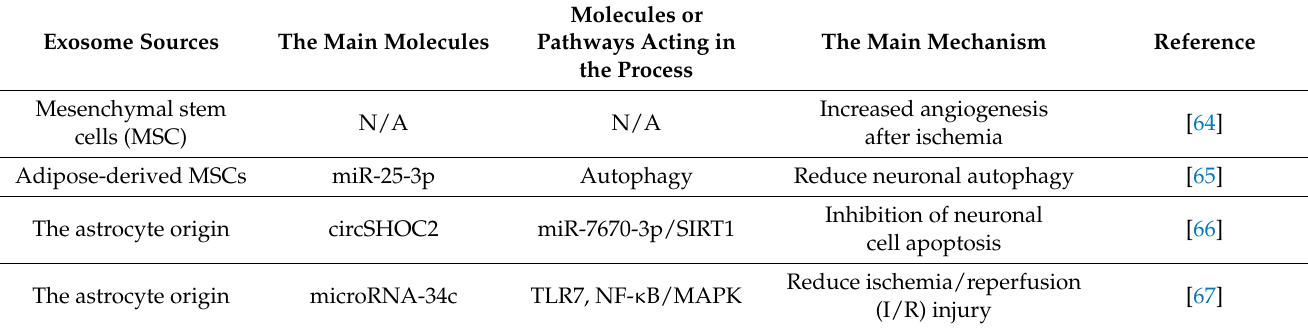
Table 2. Mechanisms of exosome